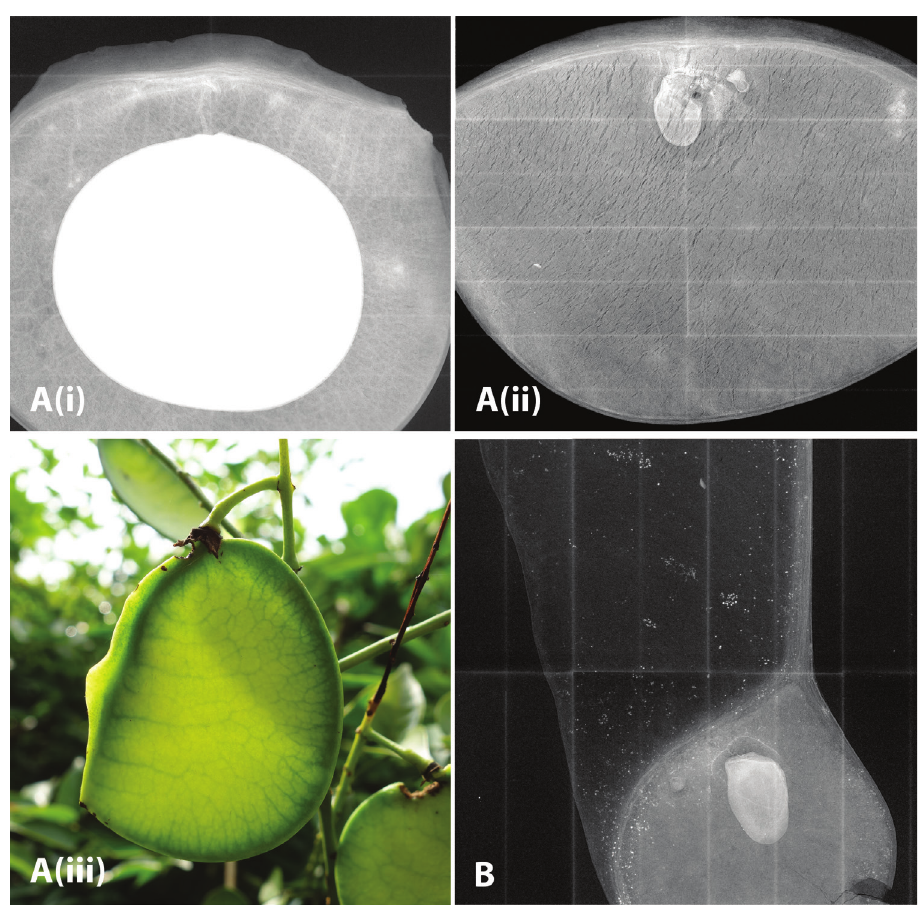
Figure 5. Fruit wing venation A T. sinensis fruit with wing (i) (X-ray) ( Z. Zhang 148 , China (MO)) (ii) (X-ray) ( W.E. Qun 150 , China (K)) (iii) (photo by R.P. Clark, Guangxi, China, unvouchered ) B Pterolobium microphyllum fruit with wing (X-ray) ( C. Phengkhlai 682 , Thailand